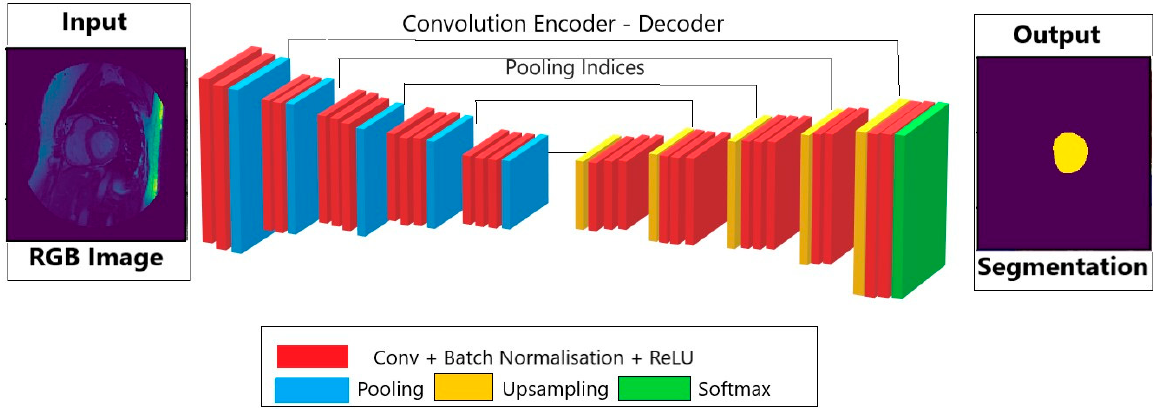
Figure 3. An example of context enabled segmentation.